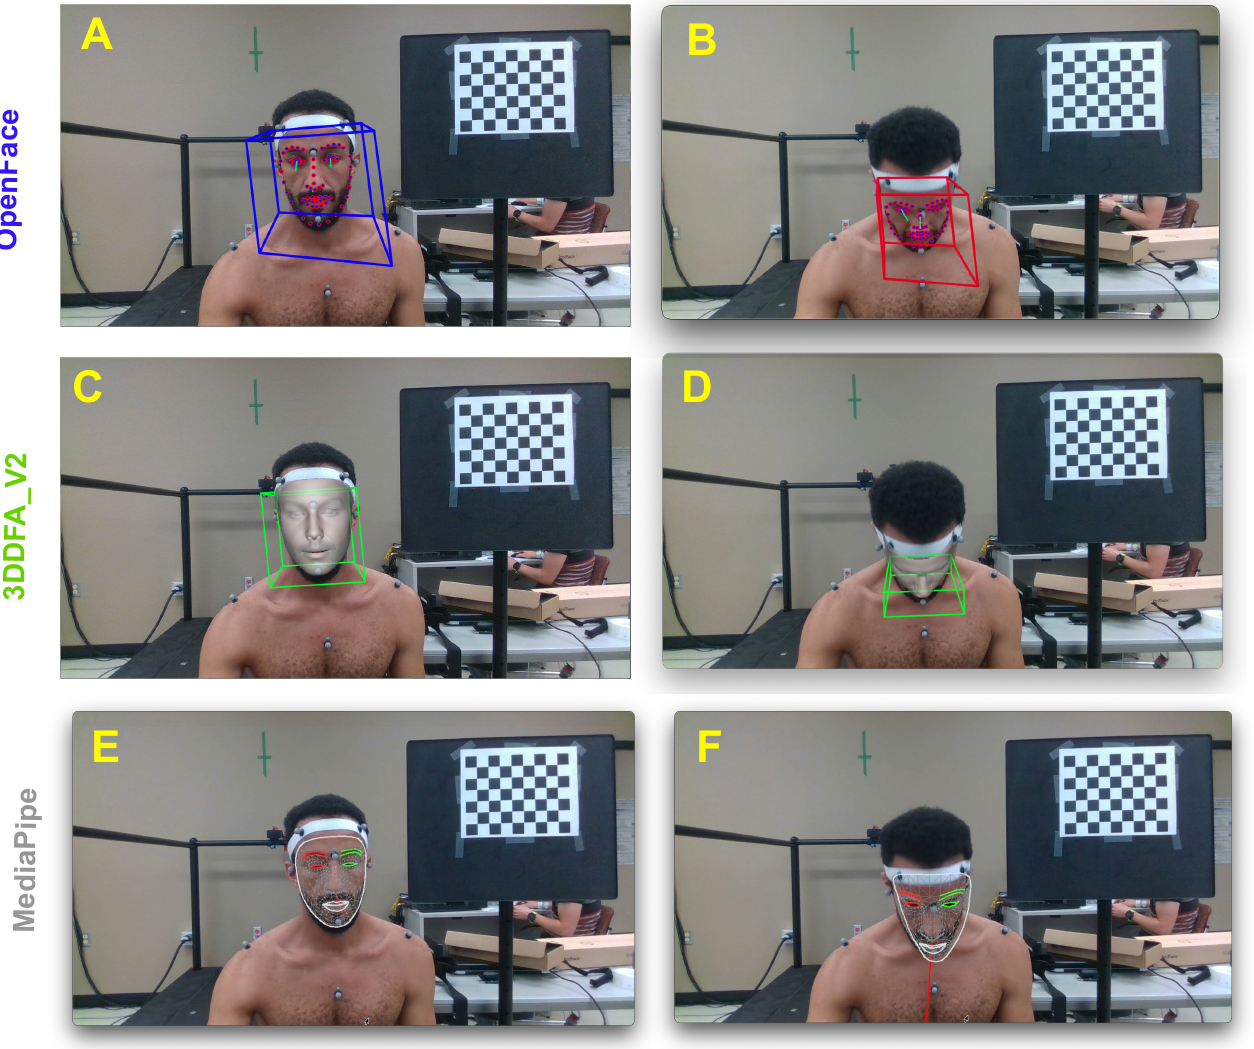
Figure 2. Head movement capture and processing examples. ( A ) Frontal pose estimation with OpenFace 2.0. ( B ) Erroneous pose estimation with OpenFace 2.0 for large pitch angle. ( C ) Frontal pose estimation with 3DDFA_V2. ( D ) Pose estimation with 3DDFA_V2 for large pitch angle. ( E ) Frontal pose estimation with MediaPipe. ( F ) Erroneous pose estimation with MediaPipe at high pitch